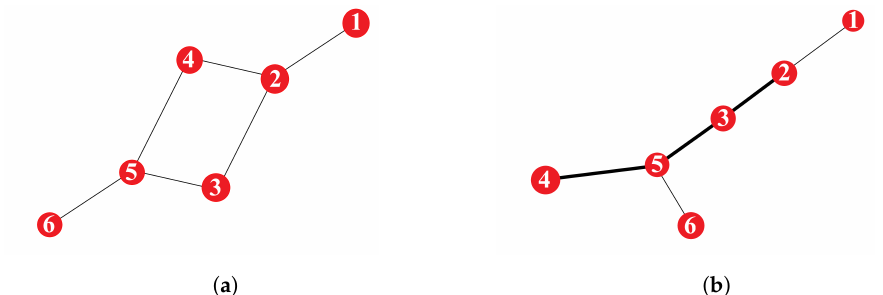
Figure 1. Segment-valve represenation and Gomory–Hu tree of a network example. ( a ) Segment- valve representation of a small example network. ( b ) Gomory–Hu tree of small example, where edges that represent more than one valve are